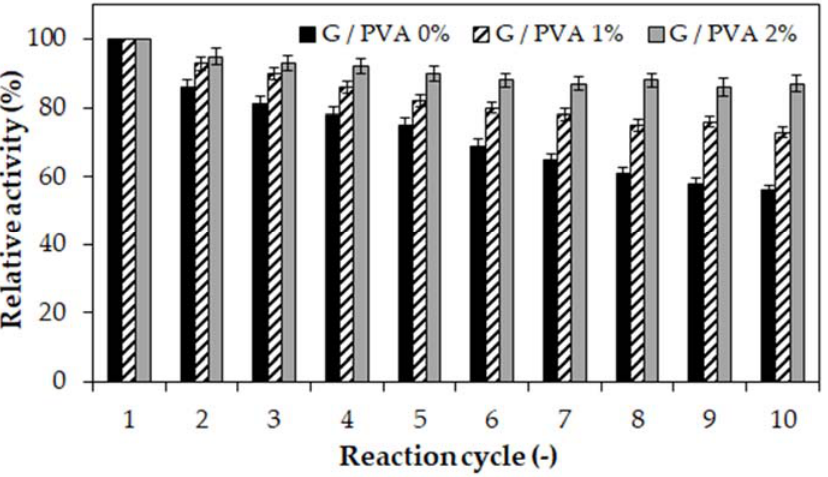
Figure 6. The relative activity of invertase immobilized in different hydrogels was determined after each of 10 consecutive reaction cycles. Enzyme entrapped in a gelatin-based hydrogel without PVA (G/PVA 0%, black), a gelatin-based hydrogel with 1% w / v of PVA (G/PVA 1%, striped), and a gela- tin-based hydrogel with 2% w / v of PVA (G/PVA 2%, grey). In each case, the concentration of gelatin was 10% w / v . The value of activity obtained in the first reaction cycle was assumed to be 100%. Mean value of three independent repetitions.